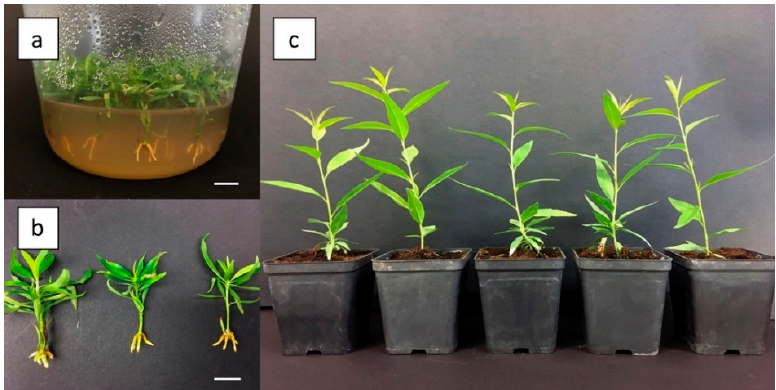
Figure 2. In vitro rooting and acclimatization of adventitious shoots from Hansen 536 leaves: (a,b) elongated and rooted in vitro adventitious shoots ready for acclimatization and (c) acclimatized rooted shoots in 7 × 7 cm